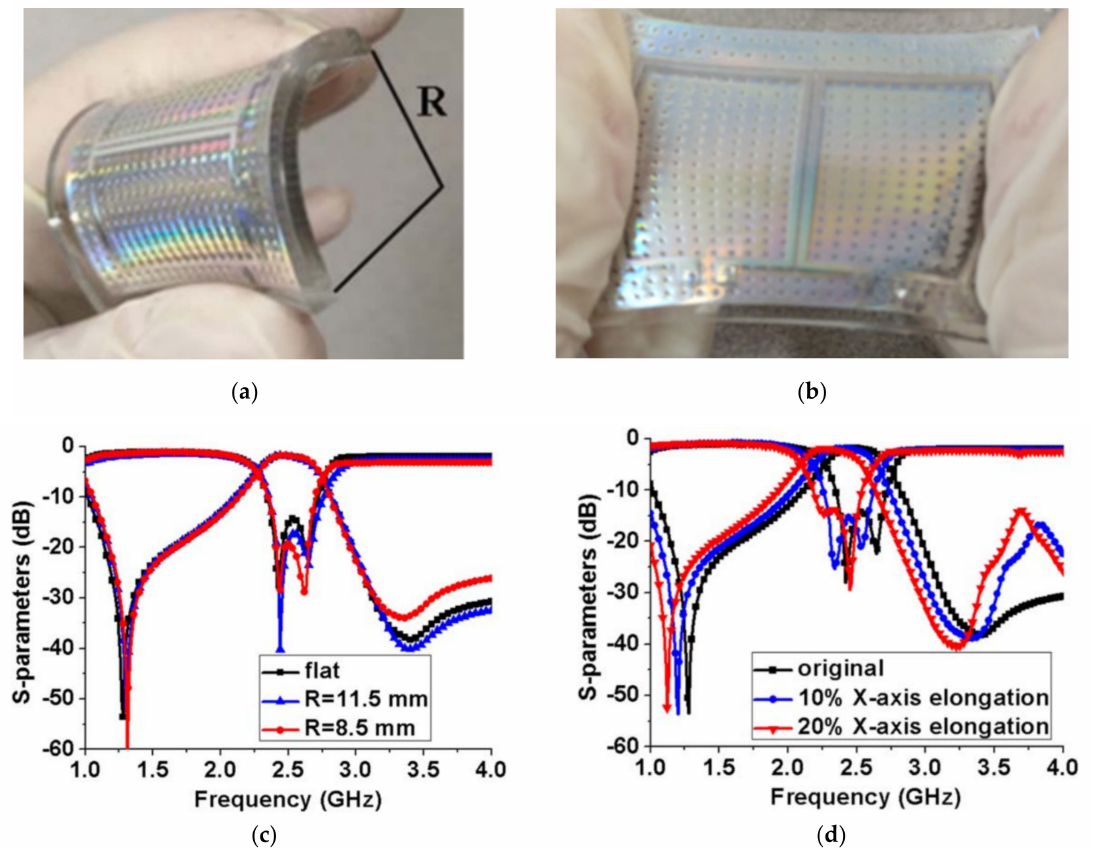
Figure 4. ( a ) Fabrication process of the bandpass filter. ( b ) Photograph of the bended filter. ( c ) Measured S-parameters of the flat filter and the bended filters. ( d ) Measured S-parameters of the original and the stretched filters. Reprinted with permission from Ref. [31]. Copyright 2018 John Wiley and